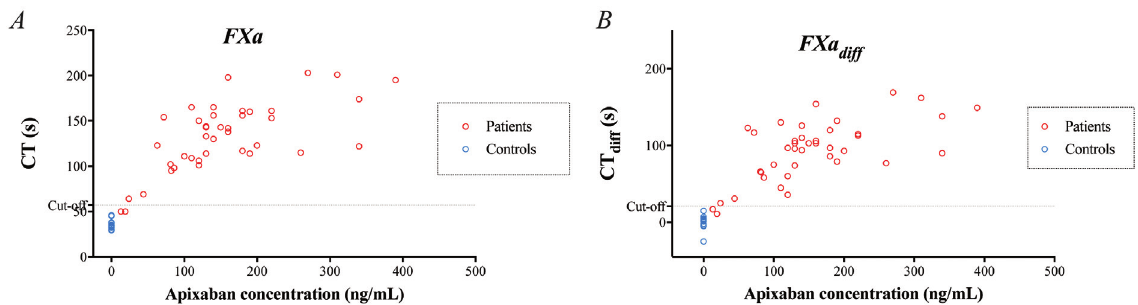
Fig. 5 Rotational thromboelastometry (ROTEM) analyses using the factor Xa (FXa) trigger – variables clotting time (CT) ( A ) and CT diff ( B ; the difference in CTwithout vs. with DOAC-Stop [DS]) – performed on blood samples from 40 patients on apixaban treatment. Variables presented in relation to apixaban concentration measured by liquid chromatography with tandem mass spectrometry (LC-MS/MS). Cutoff line represents optimal receiver operating characteristics (ROCs) for discriminating between samples with apixaban concentration above or below 20ng/mL.